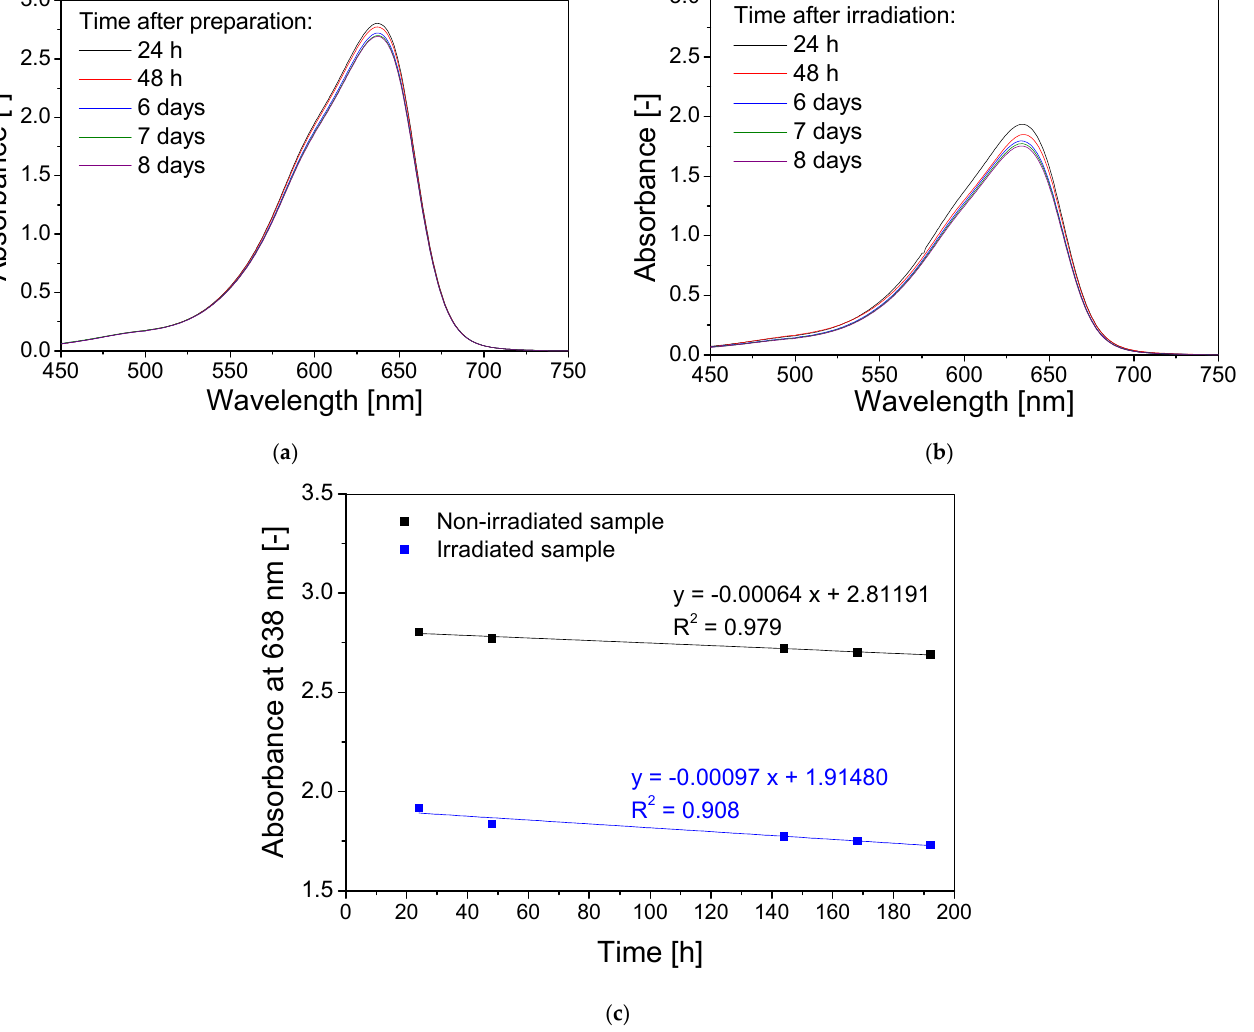
Figure 7. The stability over time of TBO ‒ Pluronic F ‒ 127 gel dosimeter (60 μ M TBO, 5% H 2 O 2 , 25% Pluronic F–127) non ‐ irradiated and irradiated with 1 J/cm 2 of UVB radiation expressed as absorbance spectra ( a , b ), for non ‐ irradiated and irradiated gels, respectively) and as absorbance at maximum wavelength versus time after preparation (for non ‐ irradiated samples) or irradiation (for irradiated samples) ( c ).